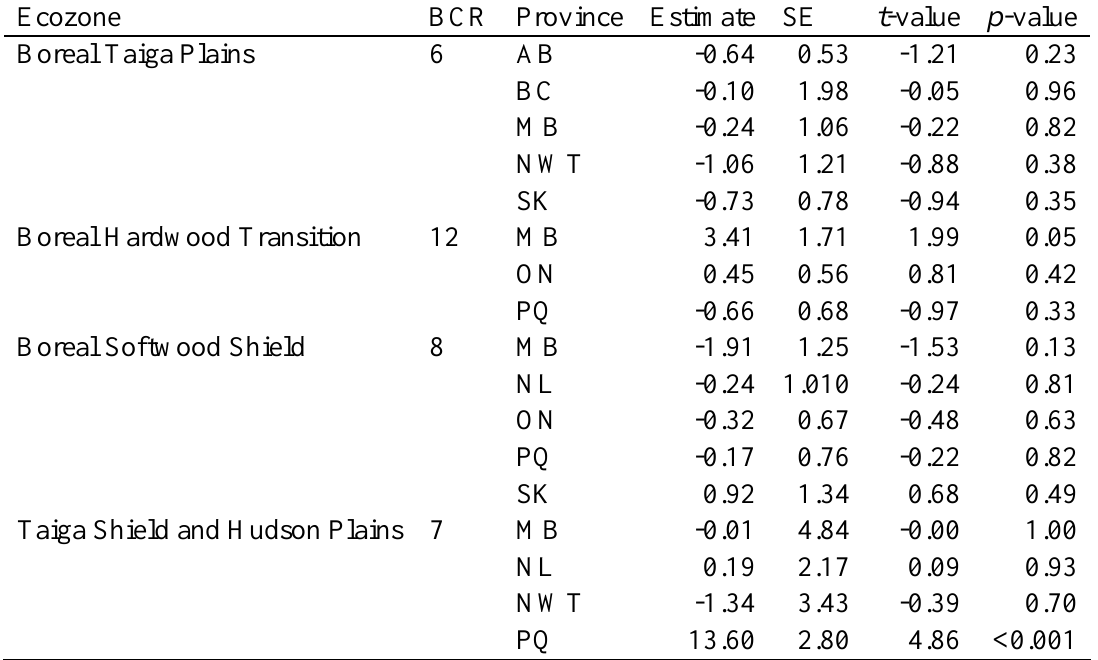
Table A1.1 Results of GAMM for bias in measurement of forest loss based on GIS analysis of 20 buffer distances between 25 – 1500m along 455 BBS routes